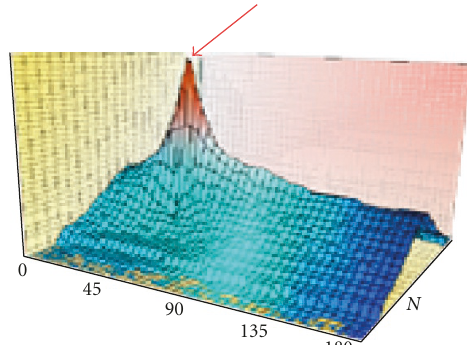
Figure 4: The result of applying Radon transform to the log of Fourier transform of an image that was degraded using linear mo- tion blur with direction 45 ◦ and no additive